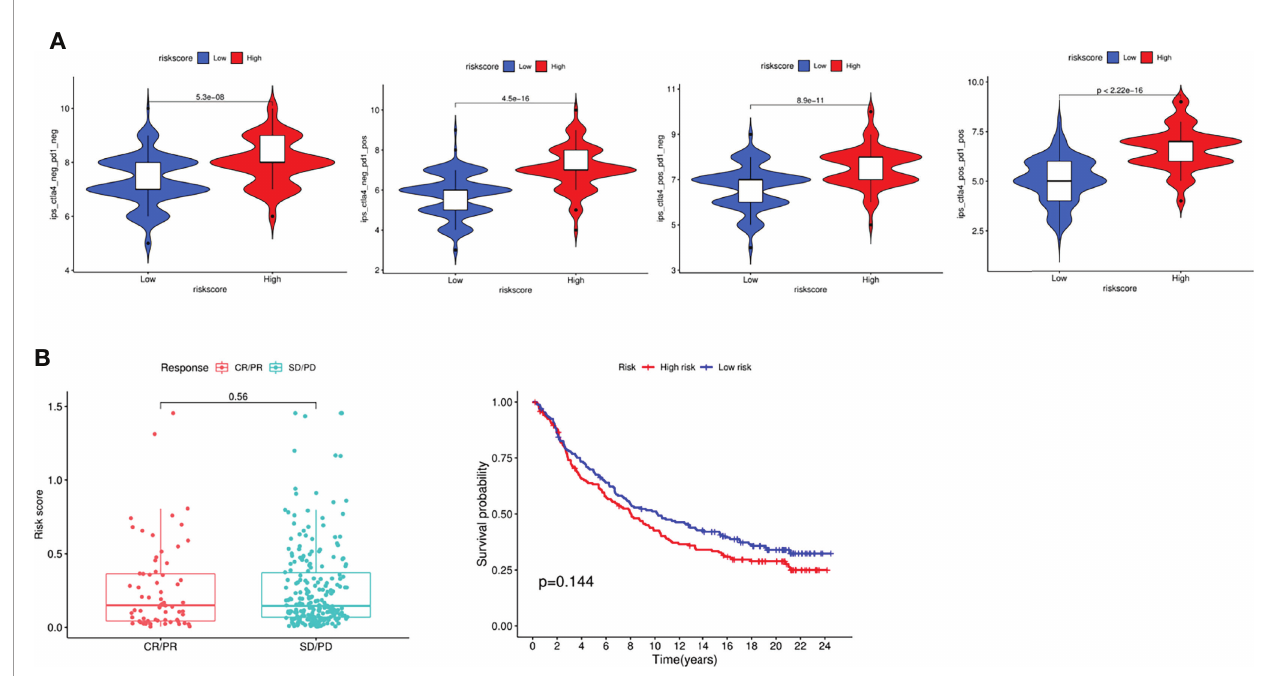
FIGURE 9 | Evaluation of Immunotherapy to CTLA-4 and PD-1. (A) Evaluation of the IPS score in different groups. (B) Response to immunotherapy and survival analysis in different